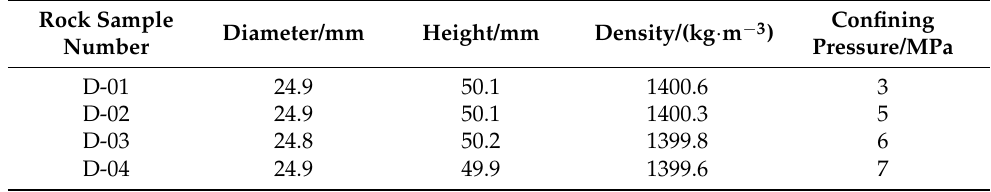
Table 1. Physical parameters and experimental. schemes of the coal samples.